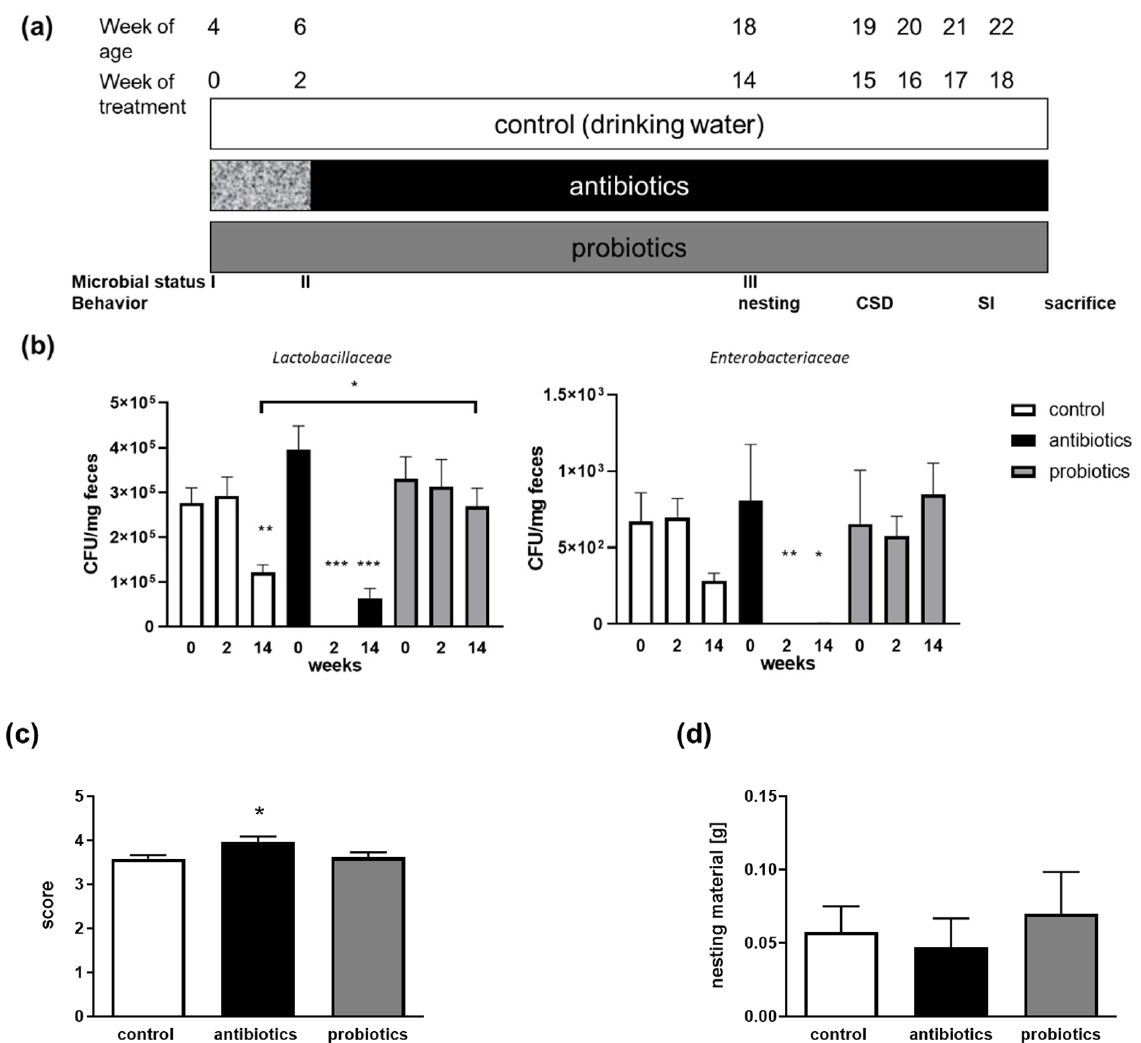
Figure 1. ( a ) Time schedule of treatment of the mice and testing. Three groups of mice were used, all male C57BL6/J. Control mice received normal drinking water throughout. Mice belonging to